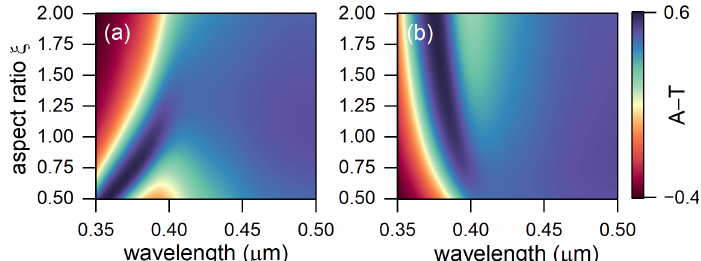
Figure 5. The difference between the absorption and transmission of the PSL from ξ and the wave- length of the incident light for polarization ( a ) perpendicular to the optical axis and ( b ) parallel to the optical axis of the